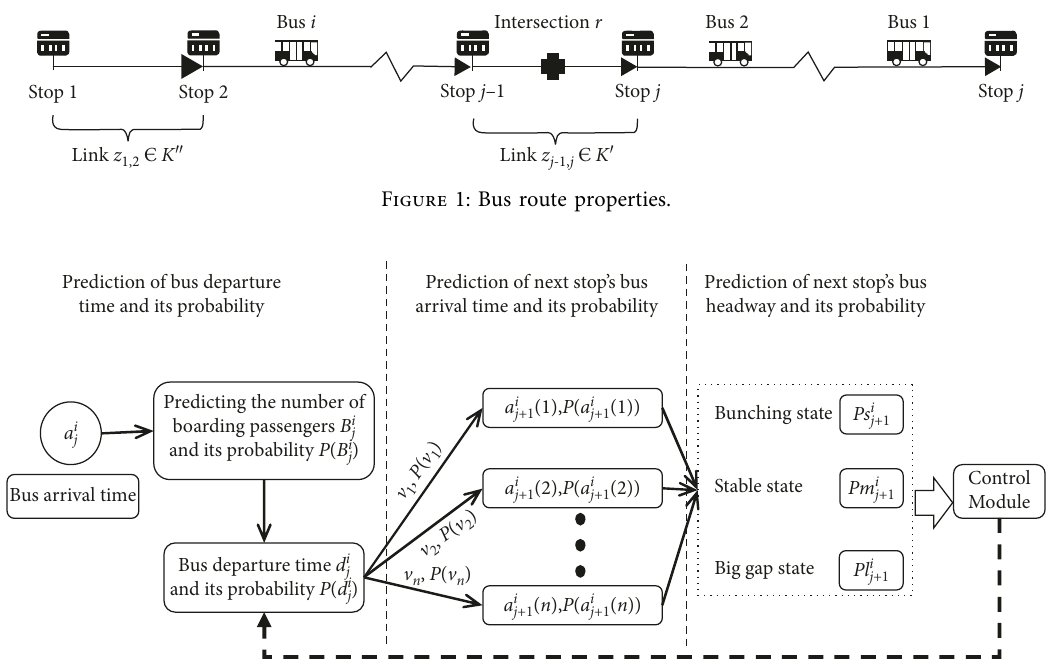
Figure 1: Bus route properties.